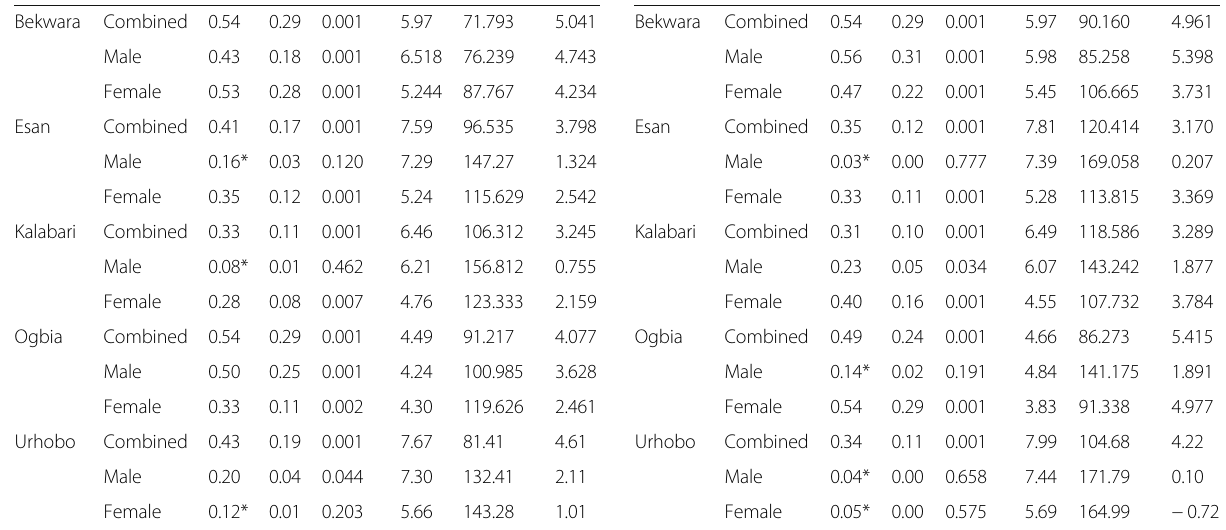
Table 4 Result of simple regression analysis between the height and head length in all the ethnic groups Ethnicity Group R R 2 p value SEE Intercept Slope Bekwara Combined 0.54